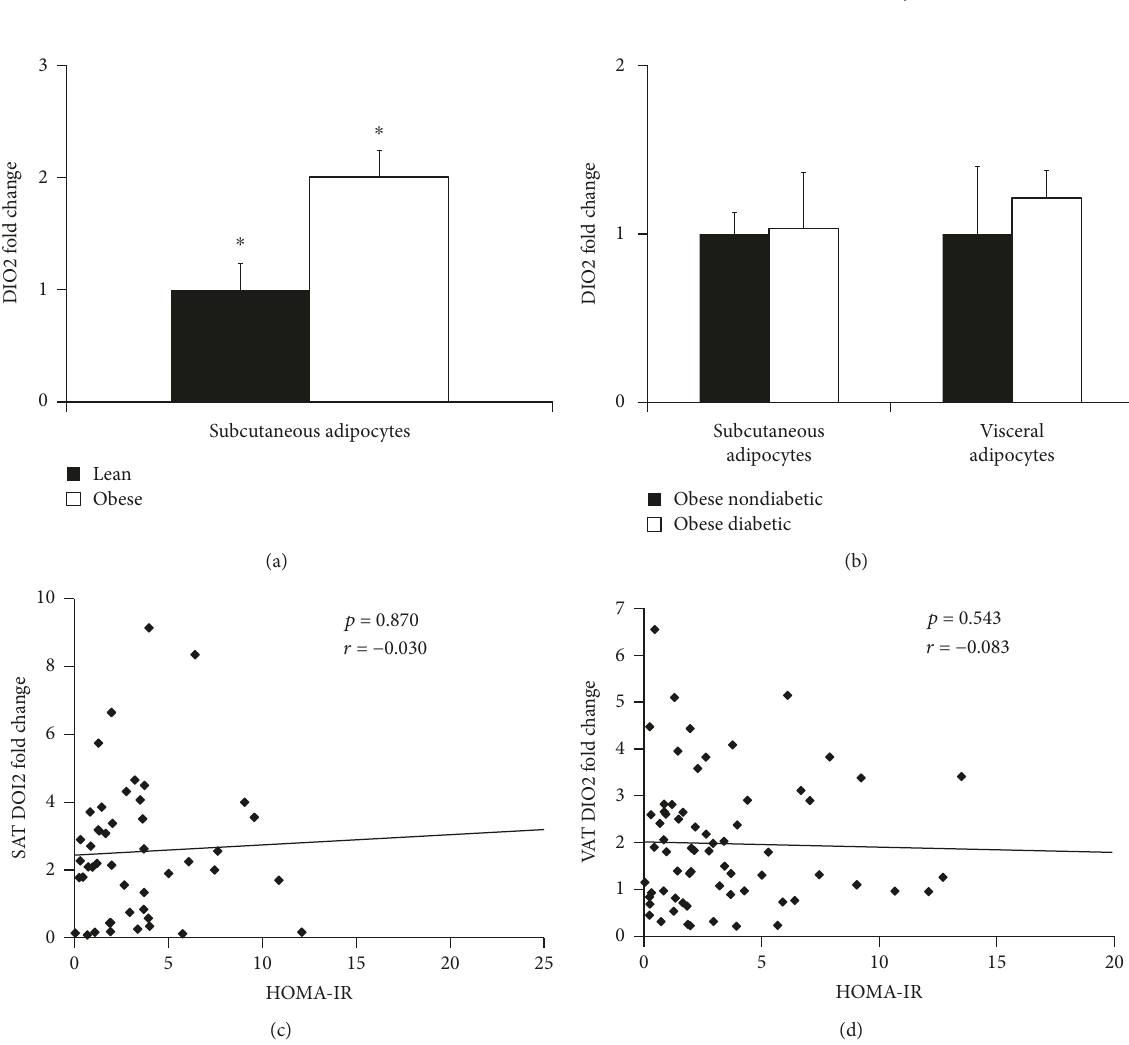
Figure 1: (a) Adipocyte expression of DIO2 in subcutaneous (SAT) and visceral (VAT) adipose tissue of lean and obese subjects and (b) obese diabetic and obese nondiabetic subjects analyzed by one-way ANOVA. Data presented as mean ± SEM. ∗ p < 0 04 . Correlation analyses (Pearson/Spearman) between adipocyte gene expression of DIO2 in SAT and VAT with HOMA-IR (c, d). HOMA-IR values used for correlation analyses were available for a subset of patients ( n = 16 lean and n = 56